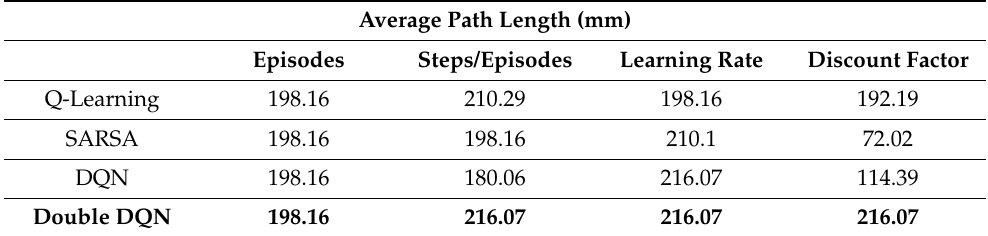
Table 2. Average Path of Different Reinforcement Learning Algorithms.